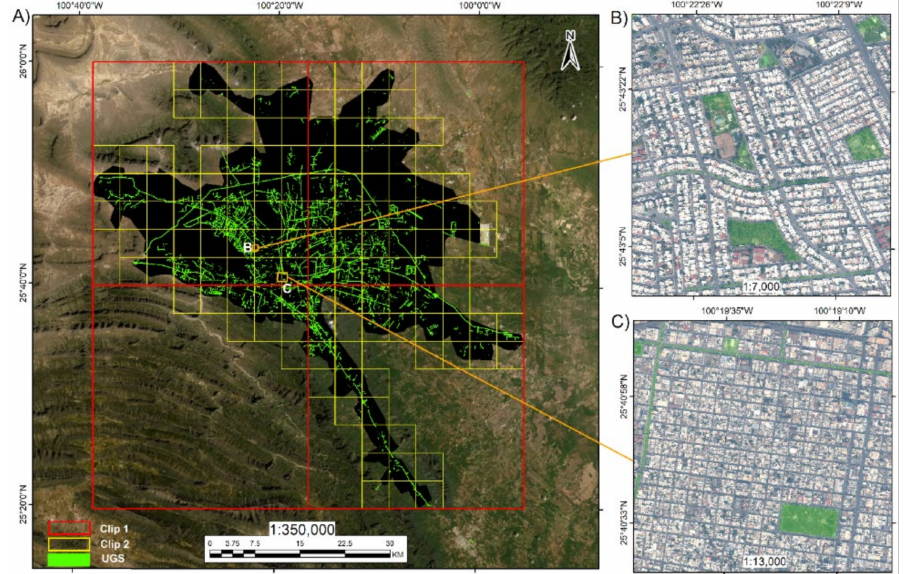
Figure 3. Production of training samples. ( A ) A 1:350,000 scale map with the result of data homoge- nization and rasterization of UGSs (light green polygons) with two raster extraction processes shown in red mosaics fishnet (Clip 1) and yellow fishnet (Clip 2). ( B ) Irregular geometry 1:7000 scale map of UGSs (light green polygons) extracted from Clip 2 and ( C ) Irregular geometry 1:13,000 scale map of UGSs (light green polygons) extracted from Clip